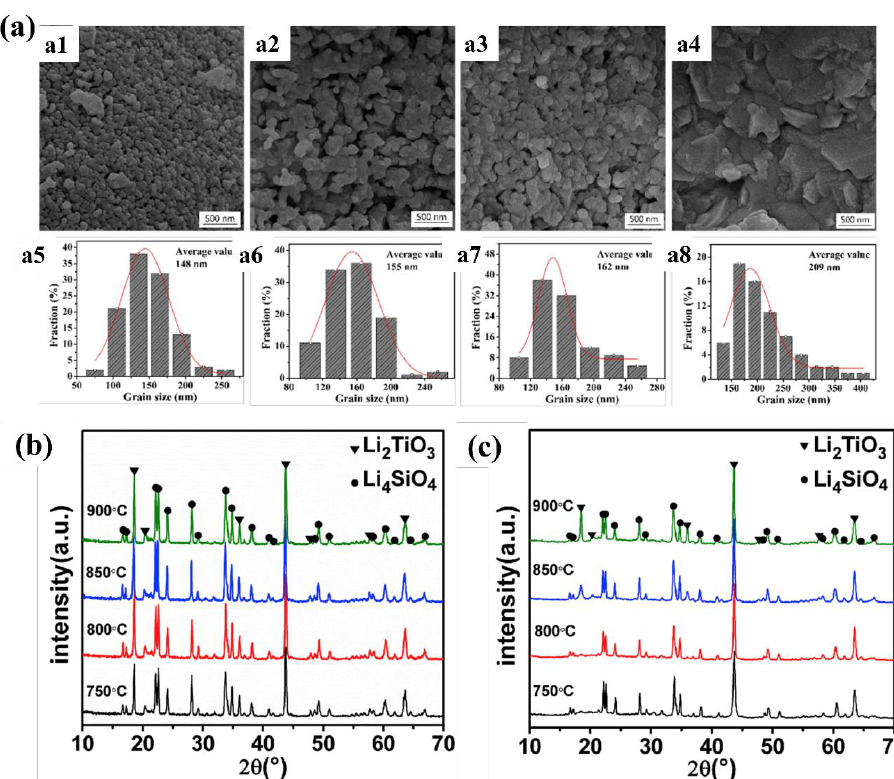
Figure 12. ( a ) Cross-section and particle size distribution of pebbles sintered at different temperatures via microwave sintering at ( a1 , a5 ) 750 ◦ C; ( a2 , a6 ) 800 ◦ C; ( a3 , a7 ) 850 ◦ C; ( a4 , a8 ) 900 ◦ C. ( b ) XRD patterns of the Li 2 TiO 3 –Li 4 SiO 4 biphasic ceramic pebbles at different temperatures via microwave sintering. ( c ) The crush load of Li 2 TiO 3 –Li 4 SiO 4 ceramic pebbles at different temperatures via microwave sintering. Reprinted with permission from ref. [132].